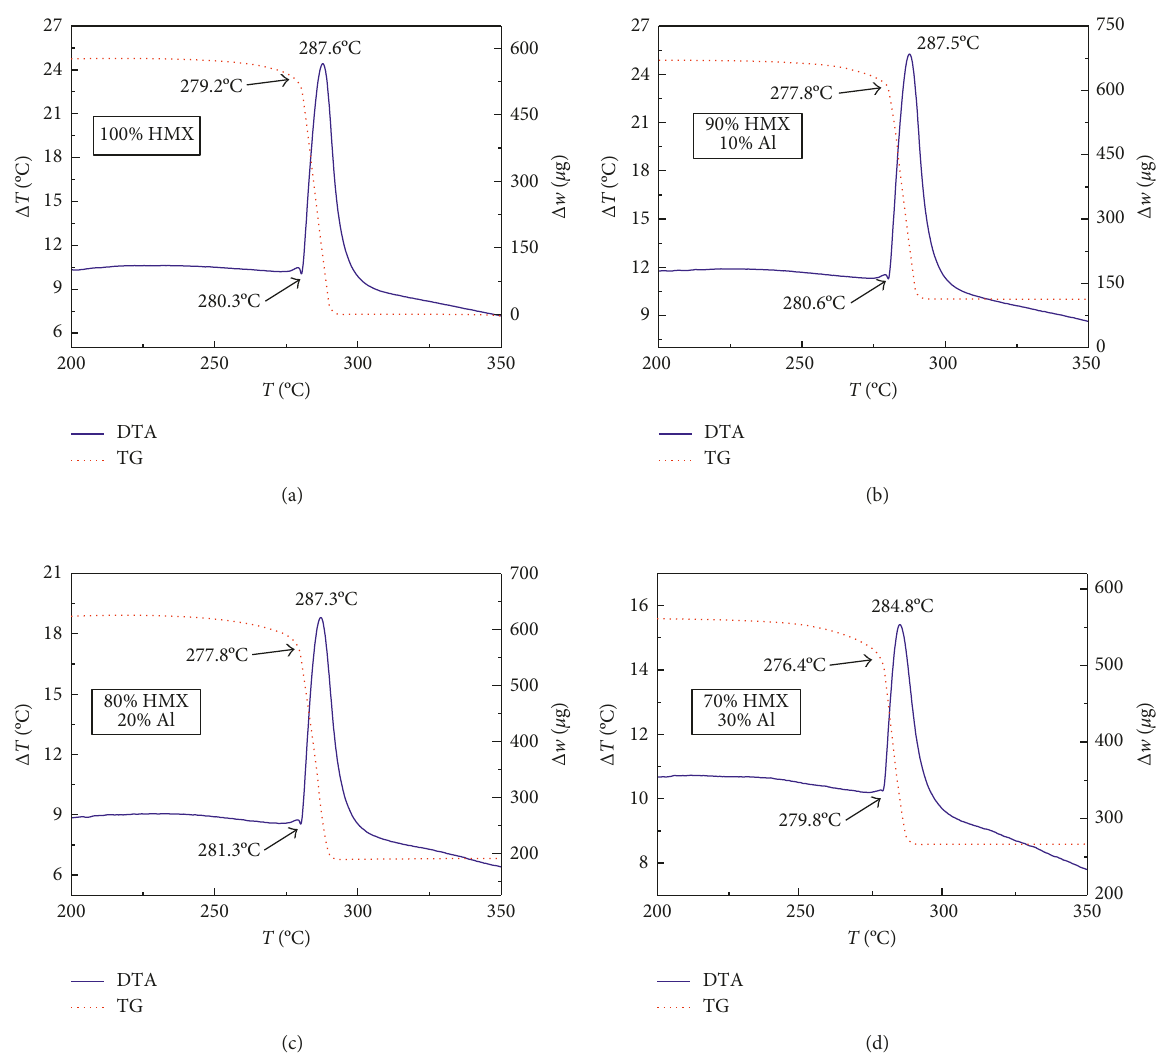
Figure 2: TG-DTA curves of HMX/Al. (a) Pure HMX; (b) HMX 90 wt.% and Al 10 wt.%; (c) HMX 80 wt.% and Al 20 wt.%; (d) HMX 70 wt.% and Al 30